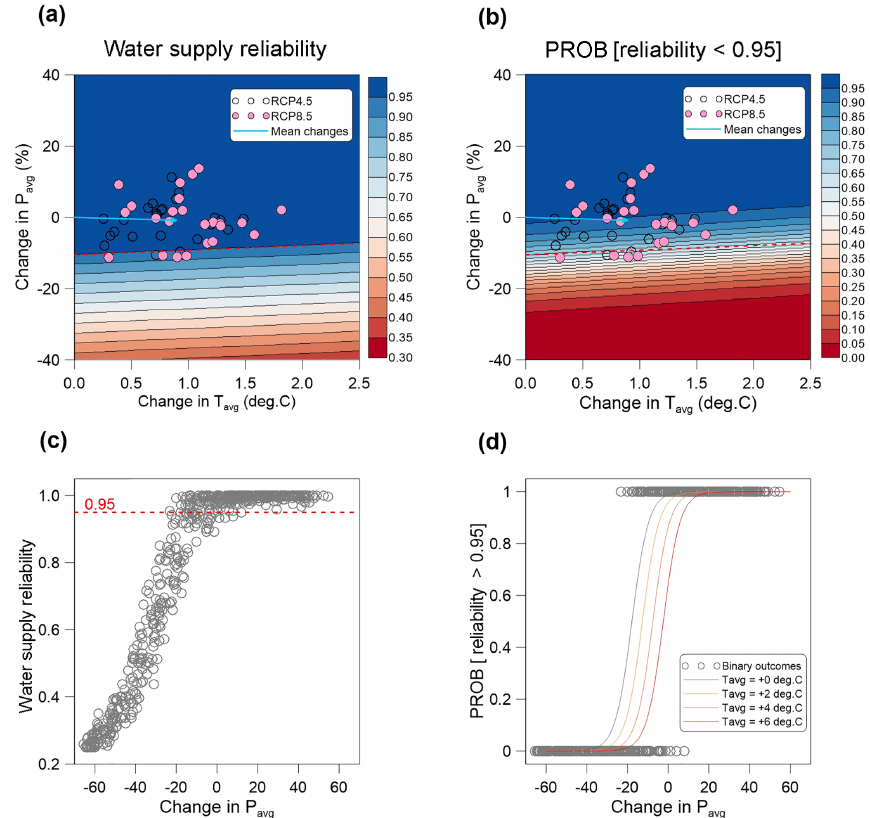
Figure 3. (a) Response surface of ρ s at the sub-basin 3011, and (b) logistic response surface of the probability of ρ s > 0 . 95. (c) The scatter plot between ρ s and change in P avg ; (d) the binary outcomes against the threshold of ρ s > 0 . 95 and the sigmoid functions for the probability of ρ s > 0 . 95. The empty and filled circles overlaid on (a) and (b) are the 50 GCM projections for 2020–2039. The dashed lines in (a) and (b) are the climatic bounds for the climatic threshold of ρ s = 0 . 95. PROB stands for probability.